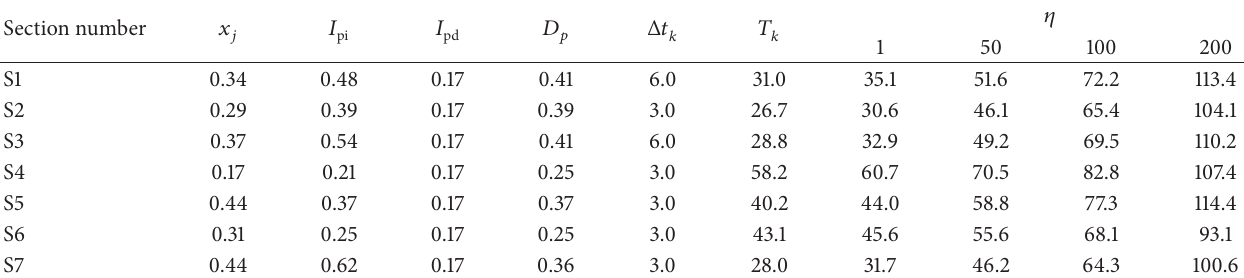
Table 5: Calculation results of degree-of-priority and emergency vehicle travel time.